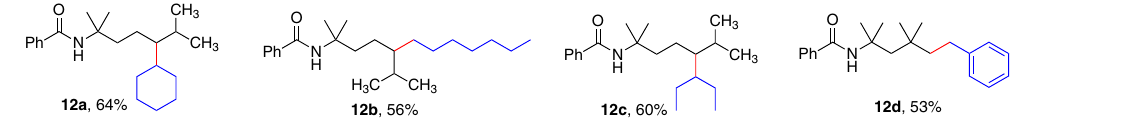
Fig. 6 Substrate scope of alkyl Hantzsch esters and nitrile. All reactions were conducted in 0.2 mmol scale. Yields referred to isolated